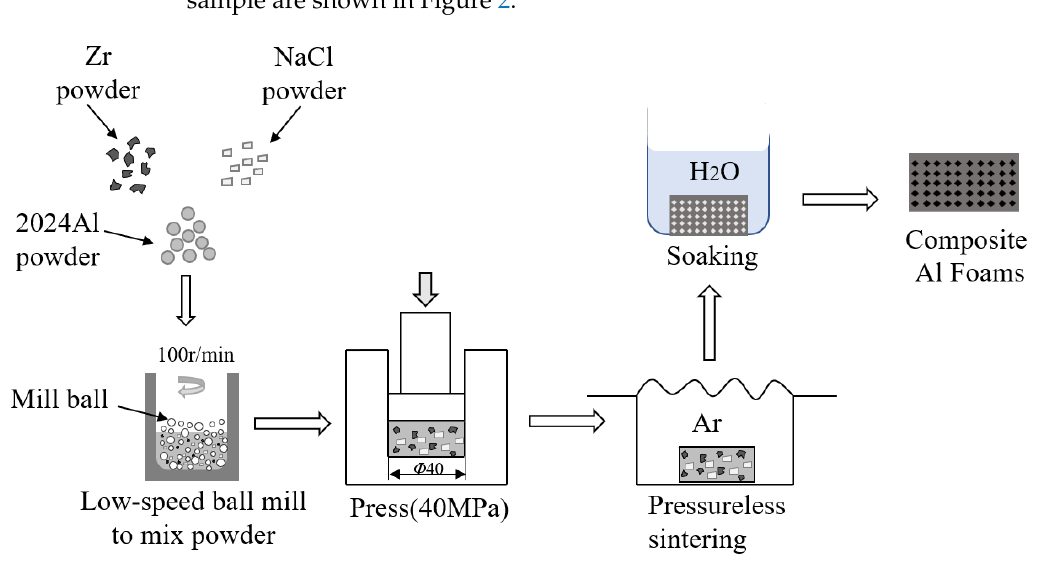
Figure 2. Schematic illustration showing the fabrication techniques for porous materials. Characterisation of the porous composite: A rectangular compressed sample with a